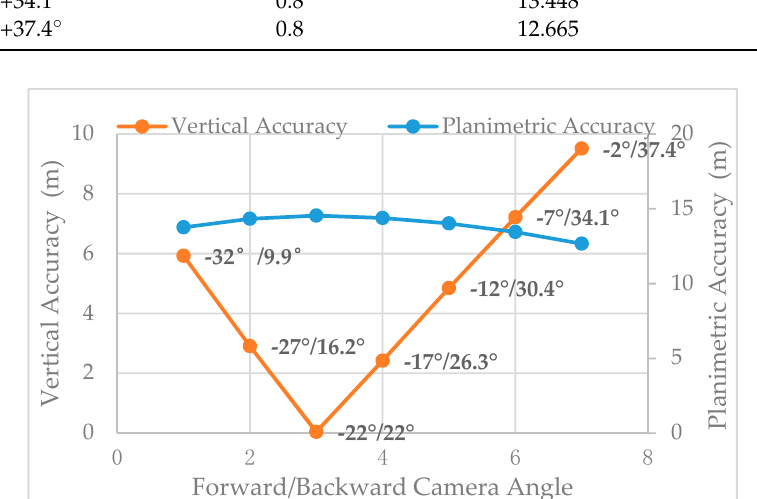
Figure 10. Vertical accuracy under the same base:height ratio.